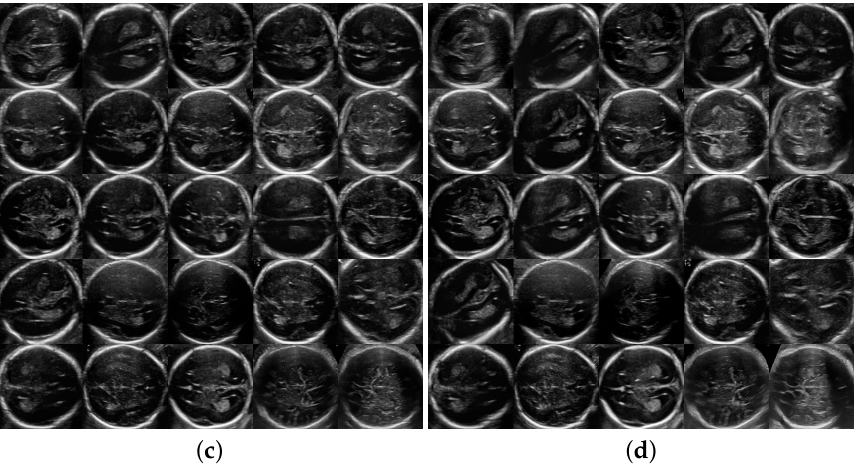
Figure 3. Generation of Trans-ventricular images for some random seeds and different ψ . Same 25 seeds were applied to each grid giving the same 25 brain plane generation for three ψ values and no truncation. ( a ) ψ = 0.3; ( b ) ψ = 0.5; ( c ) ψ = 0.7; ( d ) ψ = 1 (no truncation).